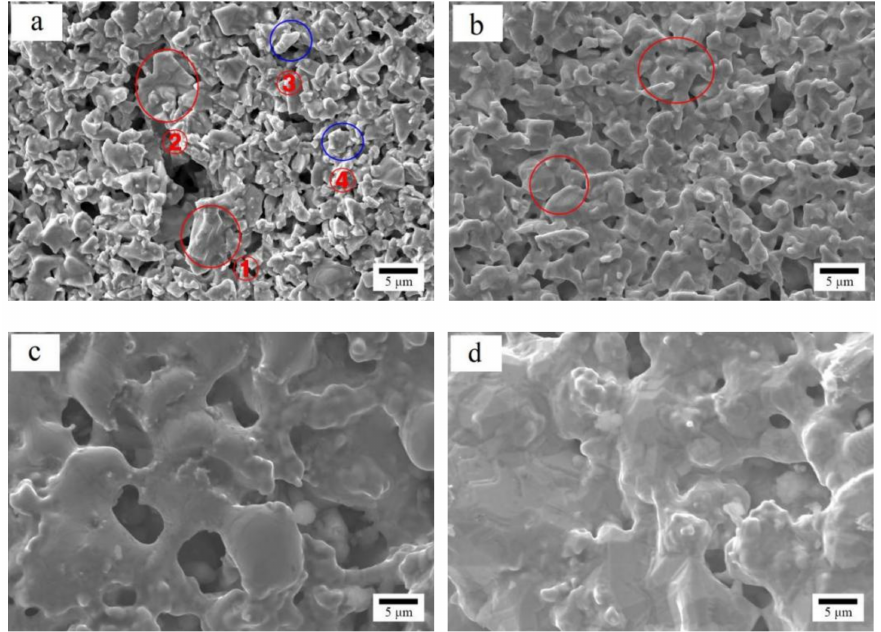
Figure 3. Microstructure of coated samples with different Cu contents by HITACHI SU1500 (2000 × , Tokyo, Japan) ( a ) x = 0; ( b ) x = 2; ( c ) x = 4; ( d ) x =